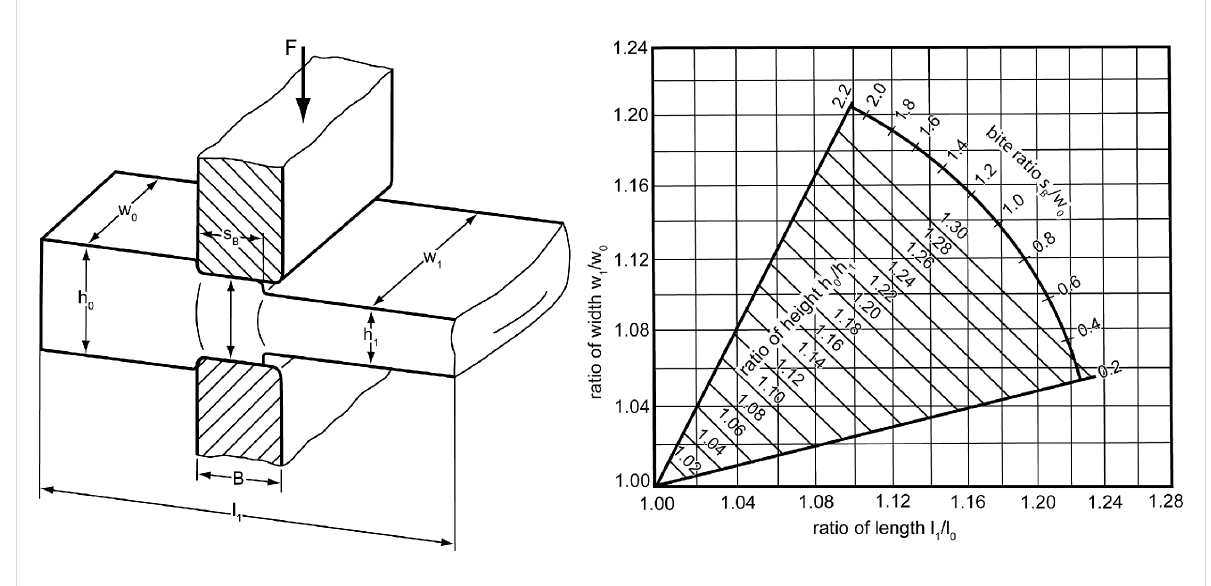
Figure 3: The grade of stretching and spreading is influenced by the bite ratio s B / w 0 . Illustrations after Spur and Stöferle [14].